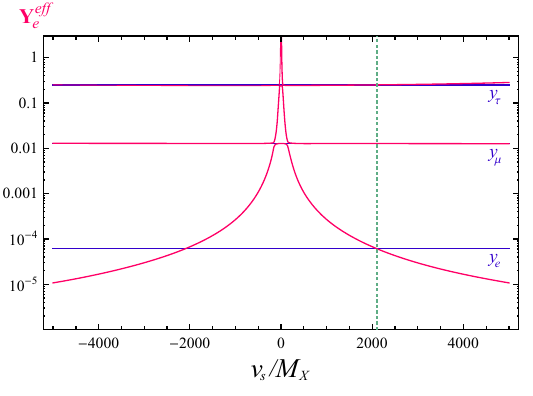
Figure 4 . Evolution of the singular values of Y e(cid:11) as given in eq. (3.23), i.e., induced by tree- e level exchanges of both the vector leptons X L;R and Z L;R . The green dashed line indicates the point at which the singular values of Y e(cid:11) coincide with the observed lepton Yukawa couplings, and e corresponds to the values quoted in eq. (3.24). Compared to (cid:12)gure 1, it now sits at a perfectly regular point, and compared to (cid:12)gure 3, even larger departures from that point have a negligible impact on the two largest singular values. The evolution as the other parameters are varied is similar as in (cid:12)gure